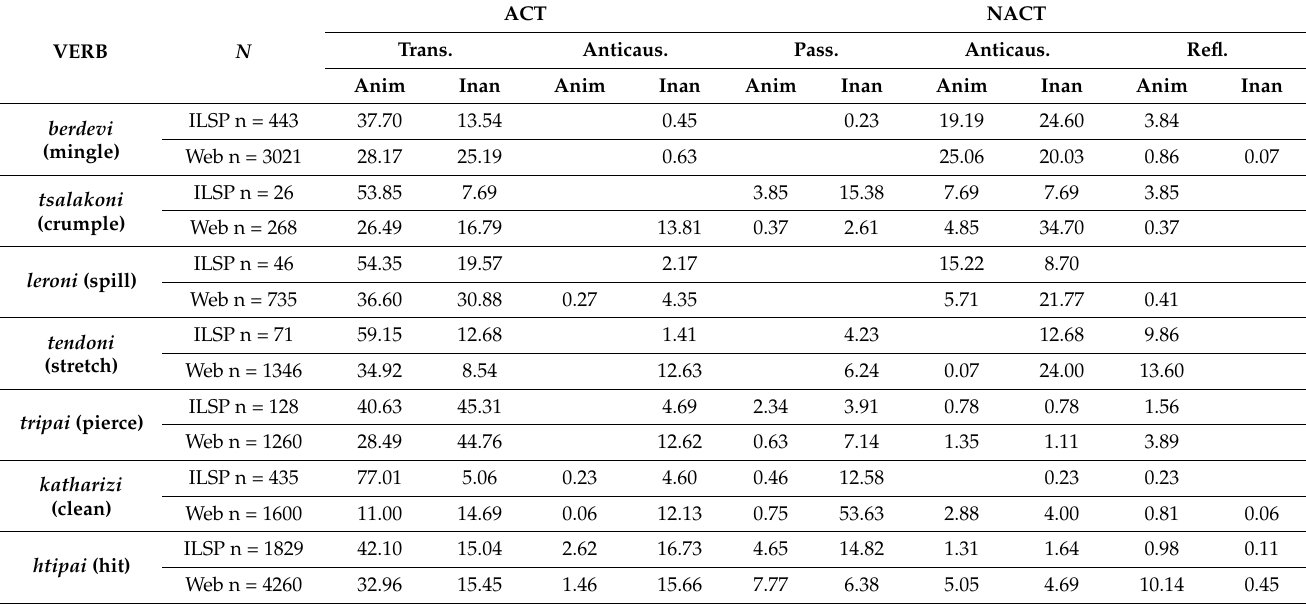
Table 2. Distribution of readings (%) among ‘voice alternating’ anticausatives by voice morphology and [+/ − animacy] of the syntactic